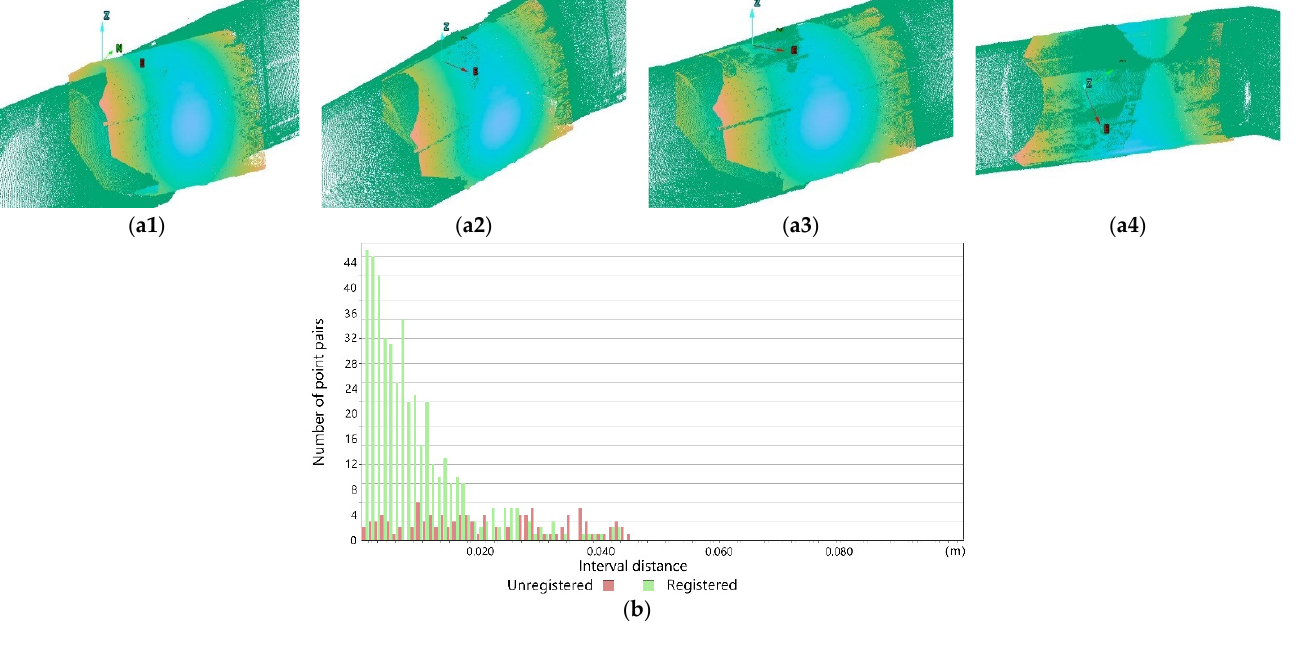
Figure 14. ( a ) Point cloud patching diagram of FPTH + ICP algorithm. ( a1 ) Initial pose; ( a2 ) Coarse registration; ( a3 ) Fine registration side view; ( a4 ) Fine registration top view. ( b ) Fine registration verification diagram.